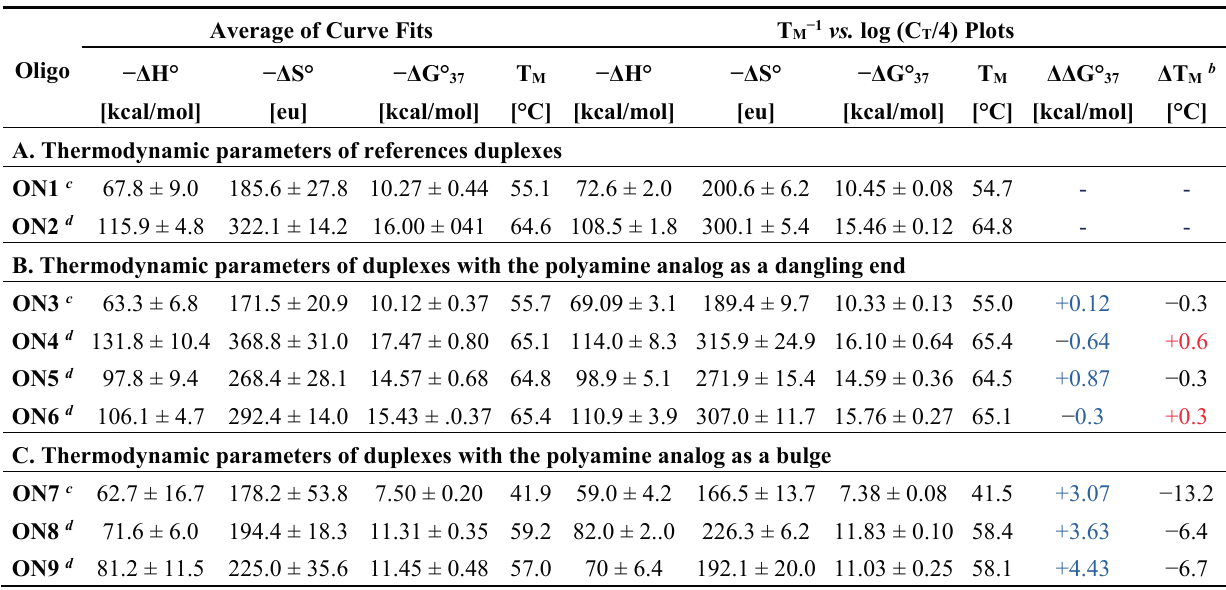
Table 2. DNA duplex stability of non-nucleosidic polyamine-modified oligodeoxyribonucleotides a . Average of Curve Fits T M − 1 vs. log (C T /4) Oligo